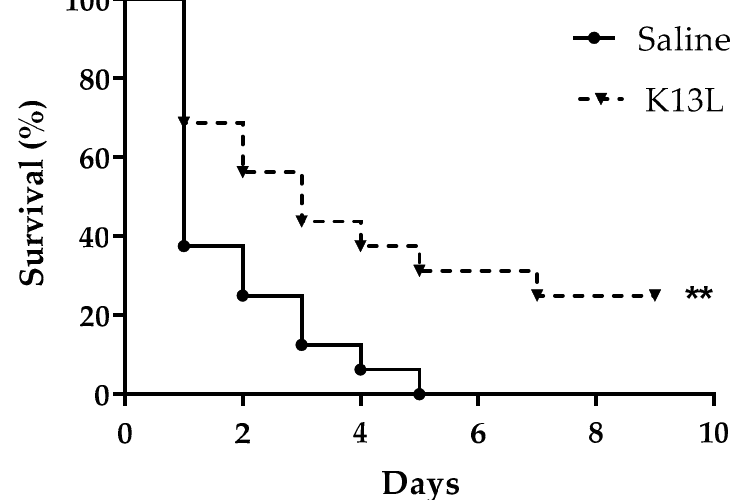
Figure 3. In vivo toxicity of K13L. ● , saline-injected larvae; ▼ , K13L-injected larvae. No significant difference in survival was found by the Mantel–Cox log-rank test.